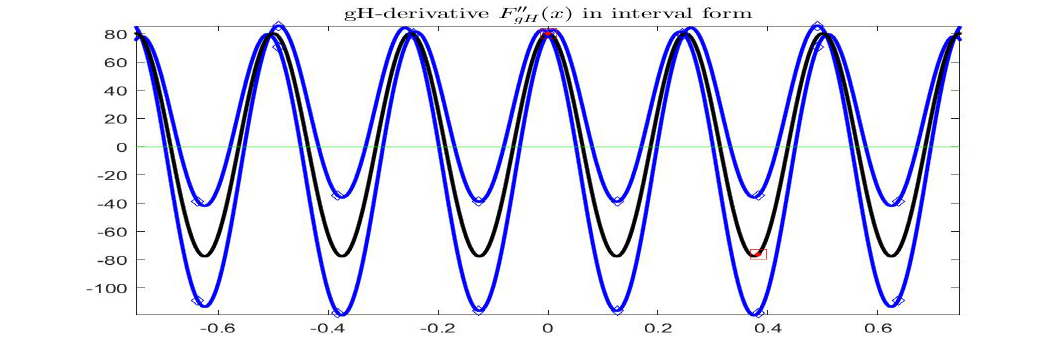
( x ) in interval form; the black curve gH